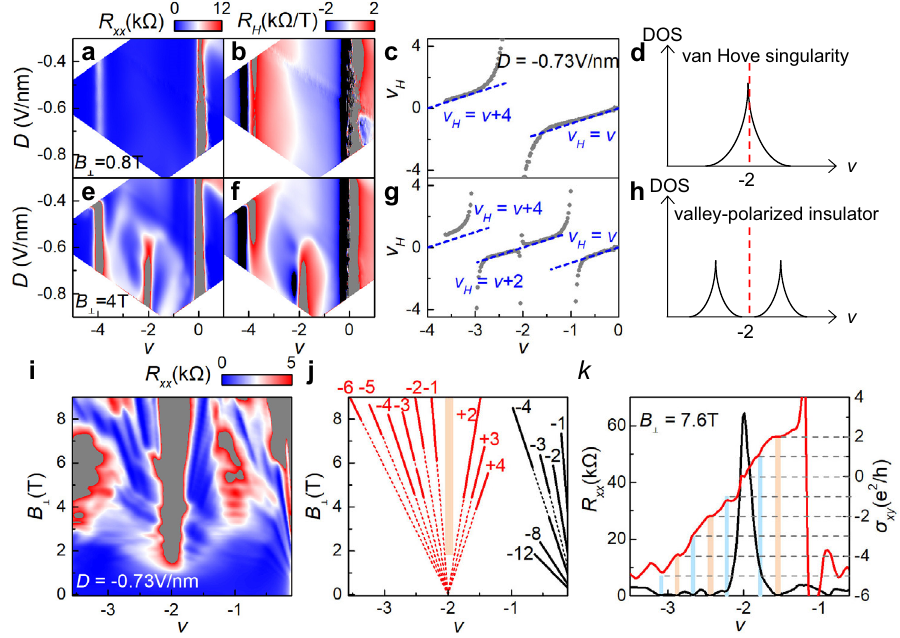
Fig. 4 Fermi surface reconstruction and Landau fan diagram of VB. a , b , e , f Longitudinal resistance R xx and Hall coef fi cient R H as a function of fi lling factor v and displacement fi eld D at B ⊥ = 0.8 T and 4 T, respectively (device D2). c , g Line cuts of mapping at D = − 0.73 V/nm show Hall fi lling factor v H as a function of fi lling factor v . d , h Schematics of density of states at B ⊥ = 0.8 T and 4 T, respectively. The red dashed line corresponds to v = − 2. i Longitudinal resistance R xx as a function of fi lling factor v and perpendicular magnetic fi eld B ⊥ at D = − 0.73 V/nm. j Schematic of LLs shown in i . Red lines correspond to the LLs emanating from v = − 2, and black lines correspond to the LLs emanating from v = 0. k Line cuts show the well-quantized σ xy = ±2 e 2 / h , − 4 e 2 / h = ± e 2 / h , − 3 e 2 / h , − 5 e 2 / h with fi nite R = 7.6 T (blue color with almost zero R xx (orange color bars) and incipiently quantized σ xx at B ⊥ xy